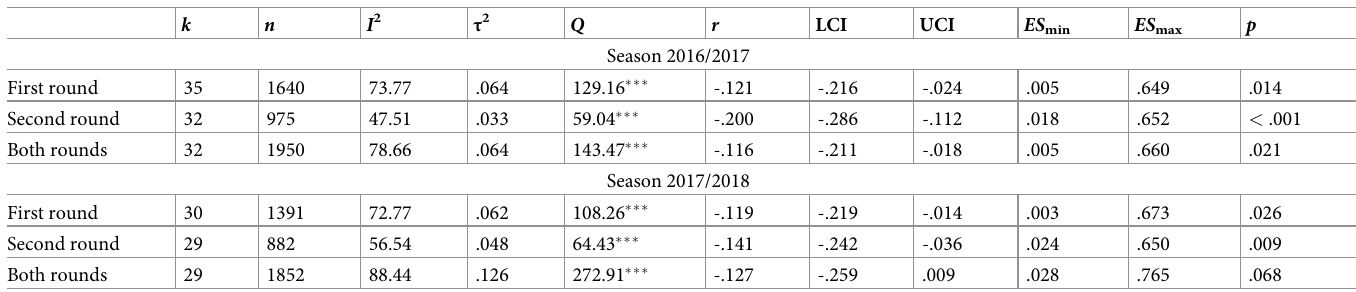
Table 1. Associations of wind points with round scores.